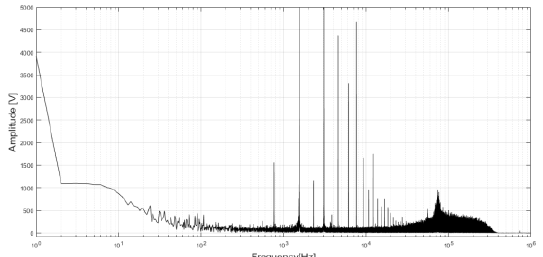
Fig. 2. Frequency spectrum of the saved signal (own